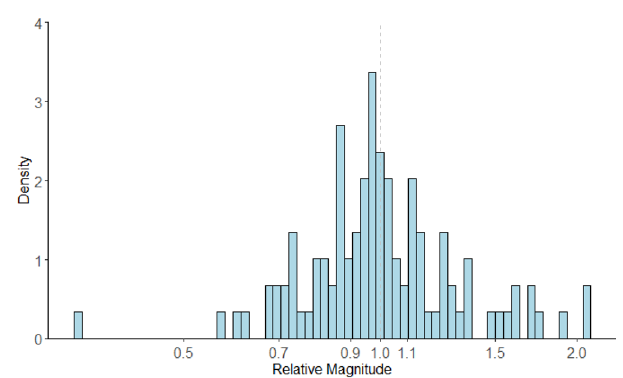
Fig.4|Distributionofrelativemagnitudeofhazardratio,riskratio,oddsratio (original/reproduction). X-axisticksonlogscale,labelsre fl ectrelativemagnitude. Dashedvertical gray line marksthe point atwhichequaleffectsizeswereobtained in the original and reproduction. Source data are provided as a Source Data fi le.